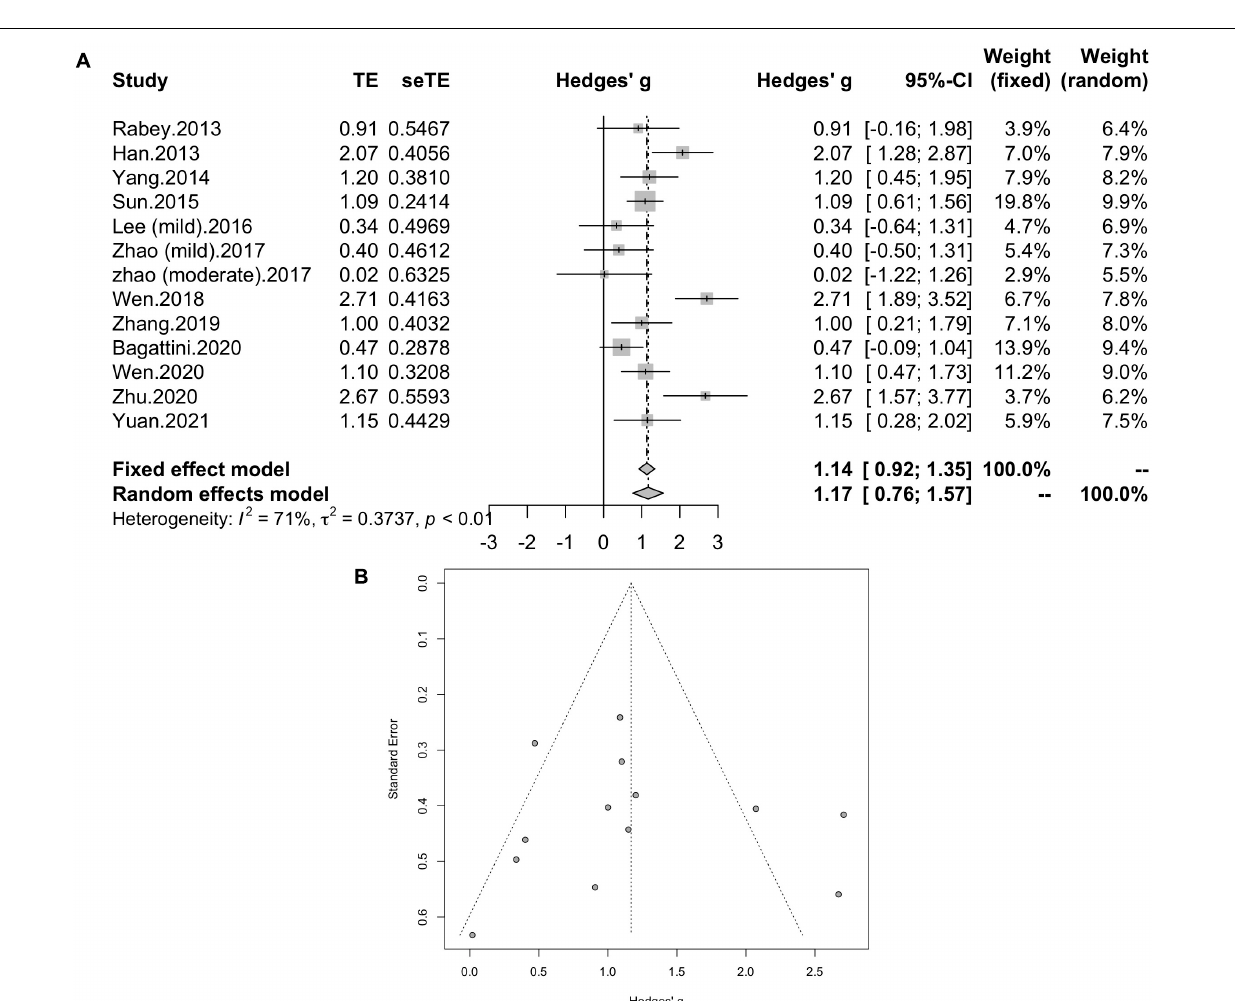
Frontiers in Cell and Developmental Biology |